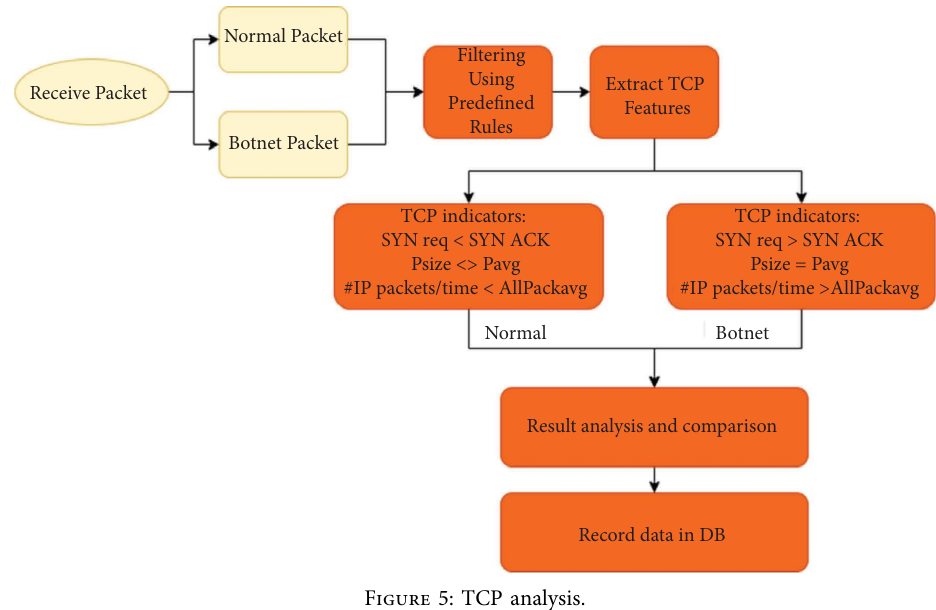
Figure 5: TCP analysis.